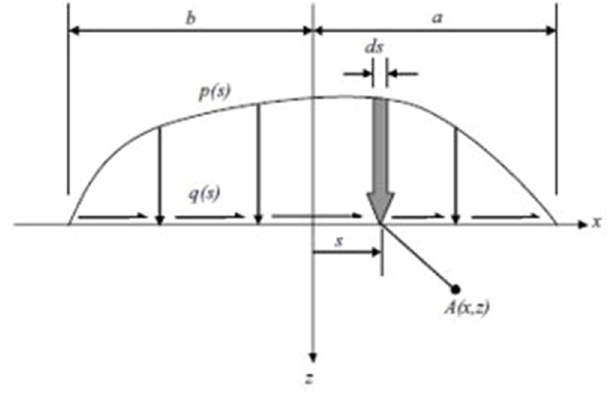
Fig. 6. Illustration of the boundary